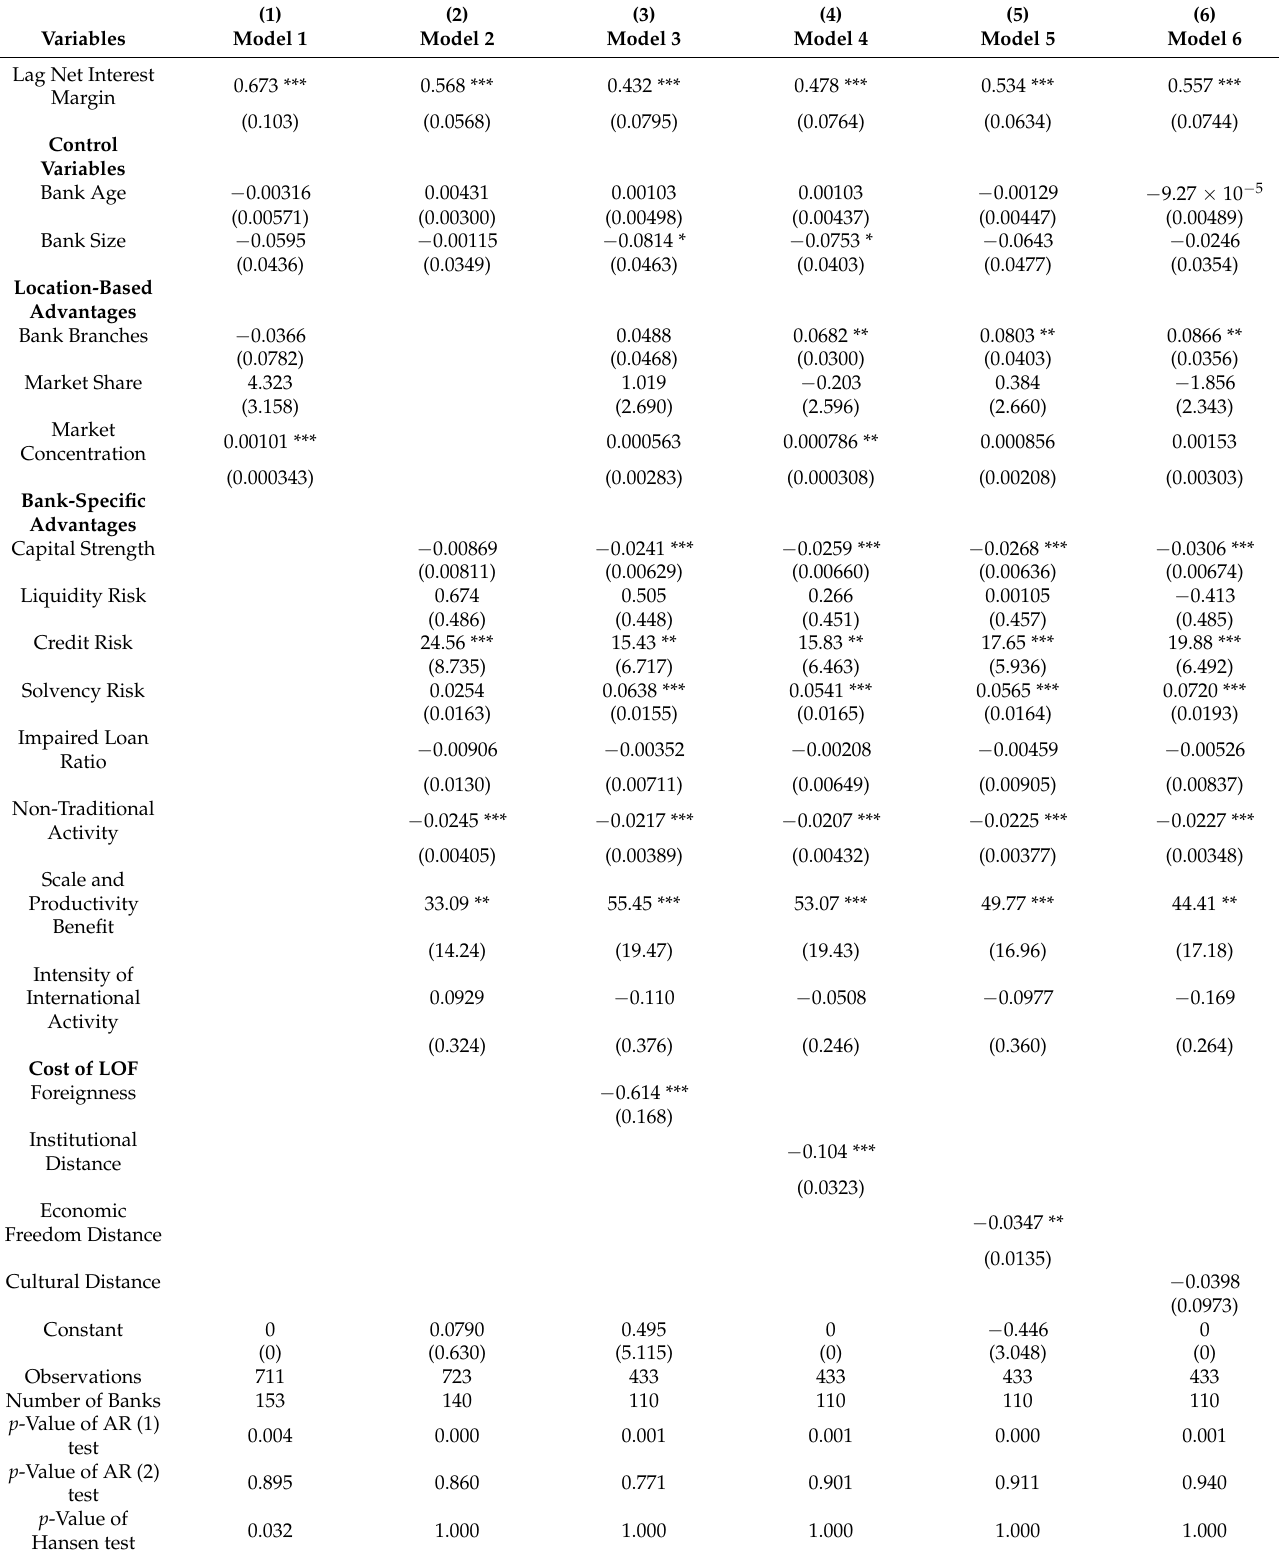
Table 5. Panel GMM model estimates (H1, H2,